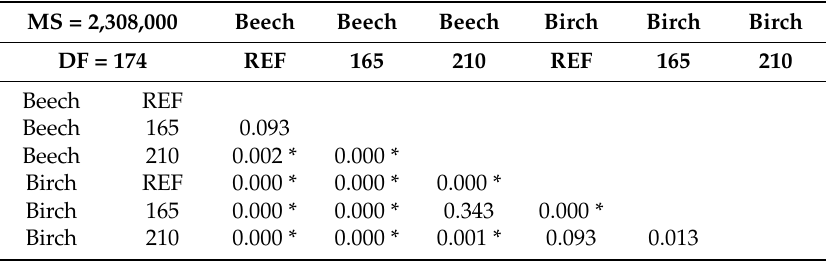
Table A4. Duncan’s Multiple Range Test for Static Modulus of